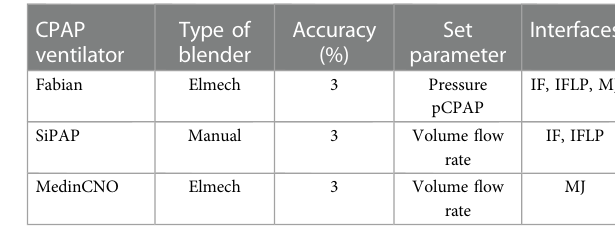
TABLE 1 CPAP ventilators and suitable interfaces used for validation of the O 2 -FS. The accuracy of ventilators is presented as reported by